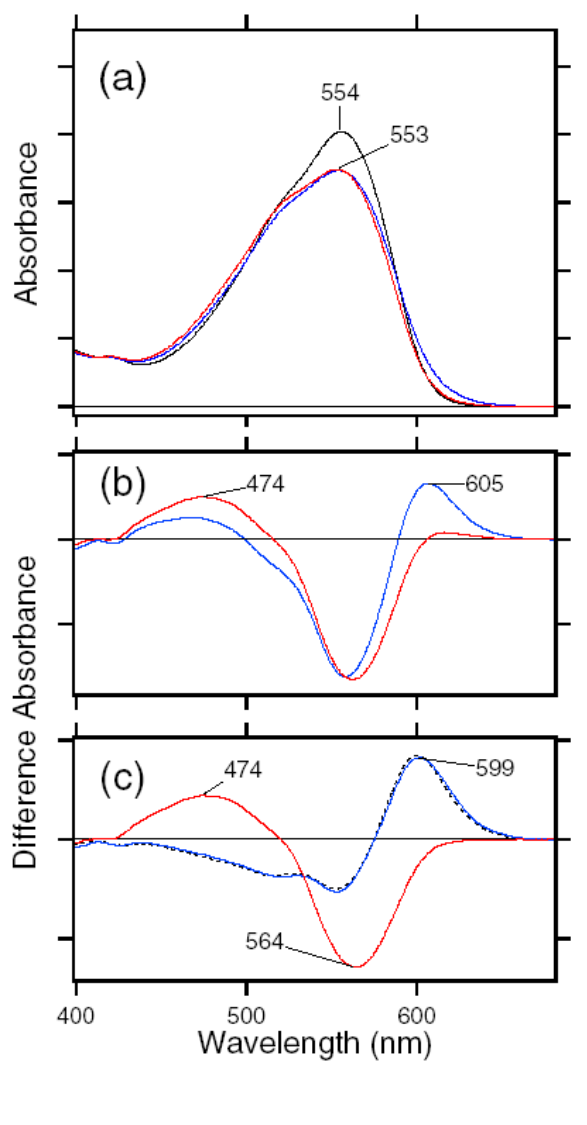
Figure 23. (Left). (a). Absorption spectra of the dark-adapted ASR (black line), illuminated with >580 nm (red line) and 501 nm (blue line) light at 170 K. It should be noted that the dark-adapted ASR corresponds to ASR , because it contains negligible amount of ASR AT 13C (2.9%) in the present sample conditions [59]. (b). Light-minus-dark difference absorption spectra of ASR with >580 nm (red line) and 501 nm (blue line) light at 170 K. (c). L minus ASR (red line) and K minus ASR (blue line) difference absorption spectra at 170 K. AT AT Black broken line corresponds to the K minus ASR spectrum at 130 K, where only the K AT intermediate is formed. See text for detail. One division of the y-axis corresponds to 0.1(a) and 0.05(b,c) absorbance units. These figures are reprinted with permission from Kawanabe et al. [71]. Copyright 2007 American Chemical